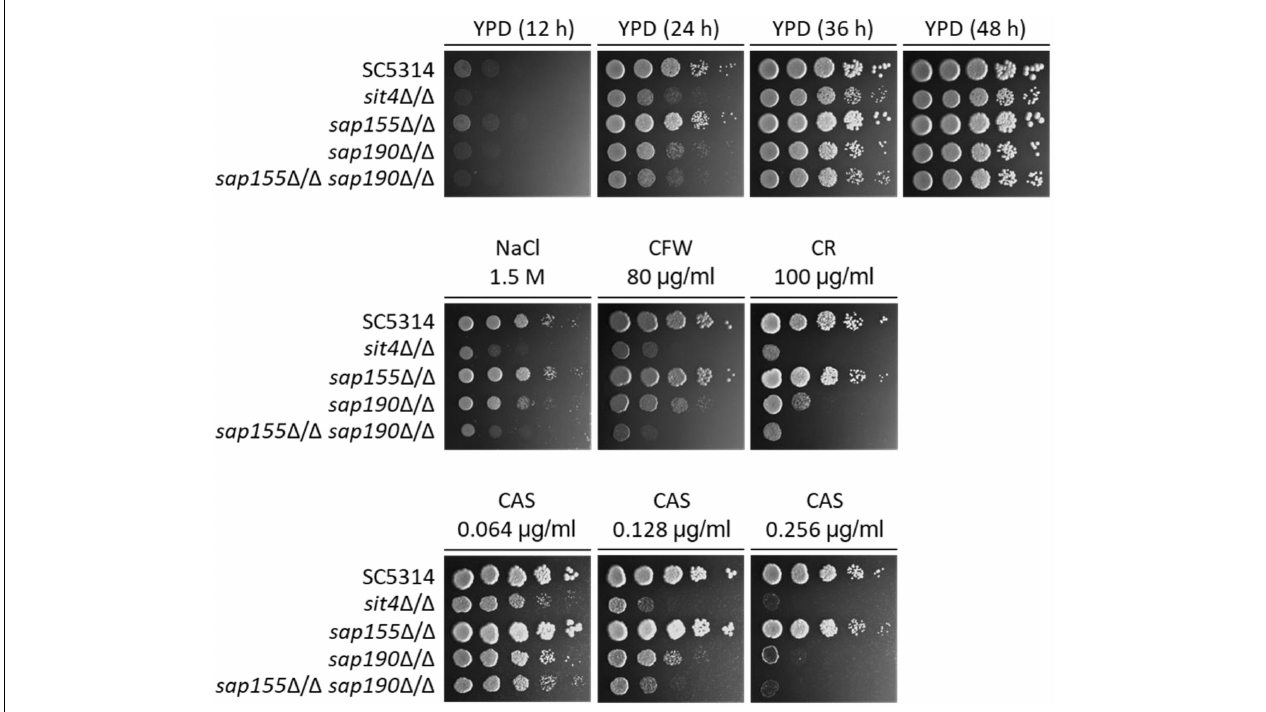
FIGURE 3 | The sensitivity to several stress agents of sit4 (cid:49) / (cid:49) , sap155 (cid:49) / (cid:49) , sap190 (cid:49) / (cid:49) , and sap155 (cid:49) / (cid:49) sap190 (cid:49) / (cid:49) mutants. Log-phase yeast cells of SC5314, sit4 (cid:49) / (cid:49) , sap155 (cid:49) / (cid:49) , sap190 (cid:49) / (cid:49) , and sap155 (cid:49) / (cid:49) sap190 (cid:49) / (cid:49) strains were serially diluted 10-fold and spotted onto YPD plates, or YPD plates supplemented with 1.5 M NaCl, 80 µ g/mL calcofluor white (CFW), 100 µ g/mL congo red (CR), 0.064/0.128/0.256 µ g/mL caspofungin (CAS). The YPD plates were incubated for the indicated times, and the YPD plates supplemented with stress agents were incubated at 30 ◦ C for 48 h. All experiments were repeated using at least 3 independent clones for each